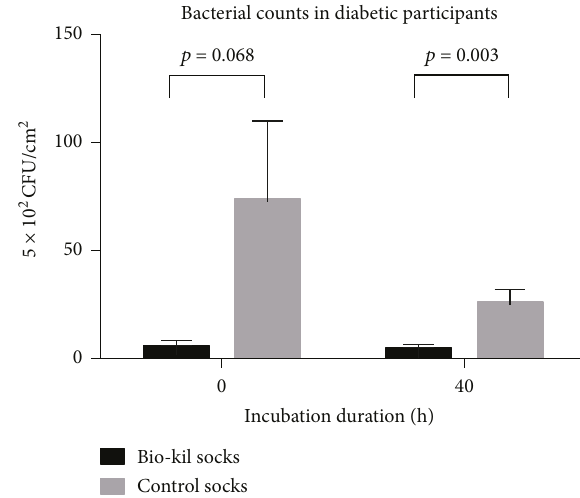
Figure 2: Bacterial counts in Bio-Kil-treated socks and control socks in diabetic patients.